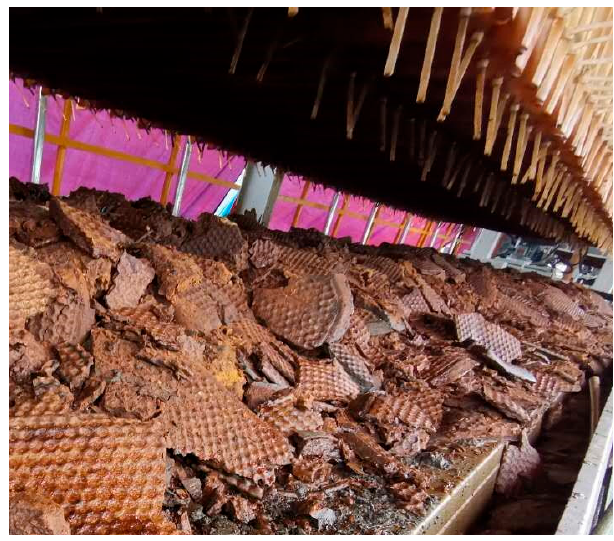
Figure 5. Dehydrated sludge produced by the plate and frame filter press.